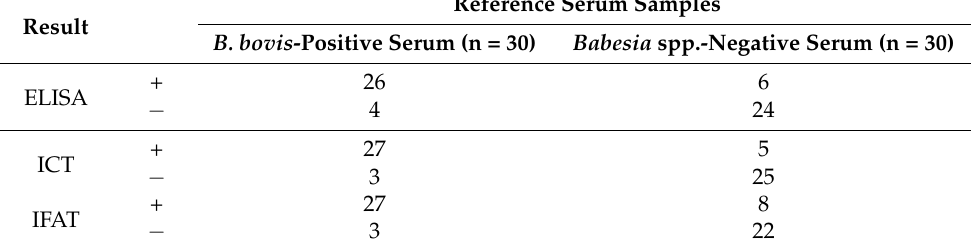
Table 1. Results of The enzyme-linked immunosorbent assay (ELISA), immunochromatography test (ICT), and indirect fluorescent antibody test (IFAT) for detection of antibodies against B. bovis in reference serum